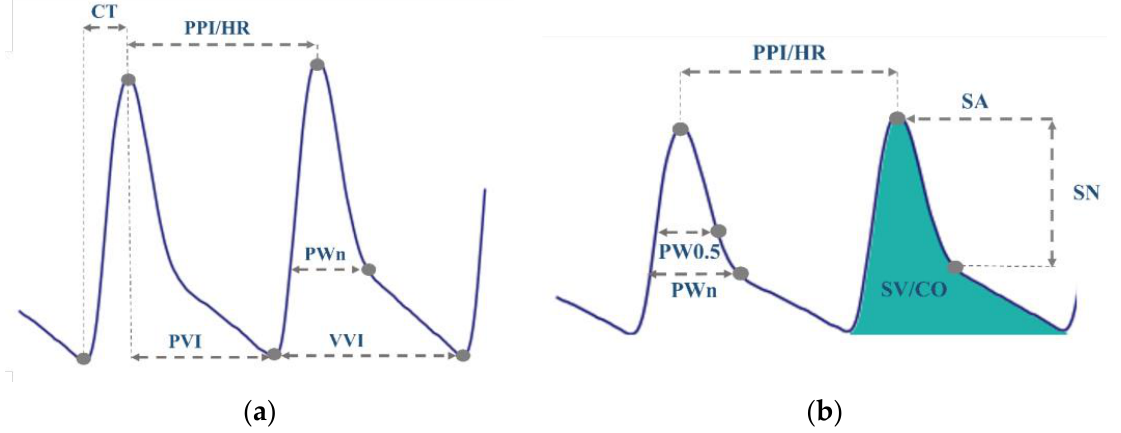
Figure 4. ( a ) Commonly Used Features Set. ( b ) Proposed Set of Features (Physiologically Motivating). The area under the curve (AUC) was computed in a valley-to-valley temporal window using the Simpson integration rule (approximated by second-order polynomial